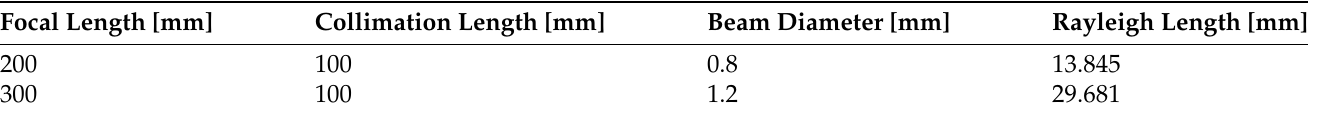
Table 3. Overview of optical parameters used in the investigation.